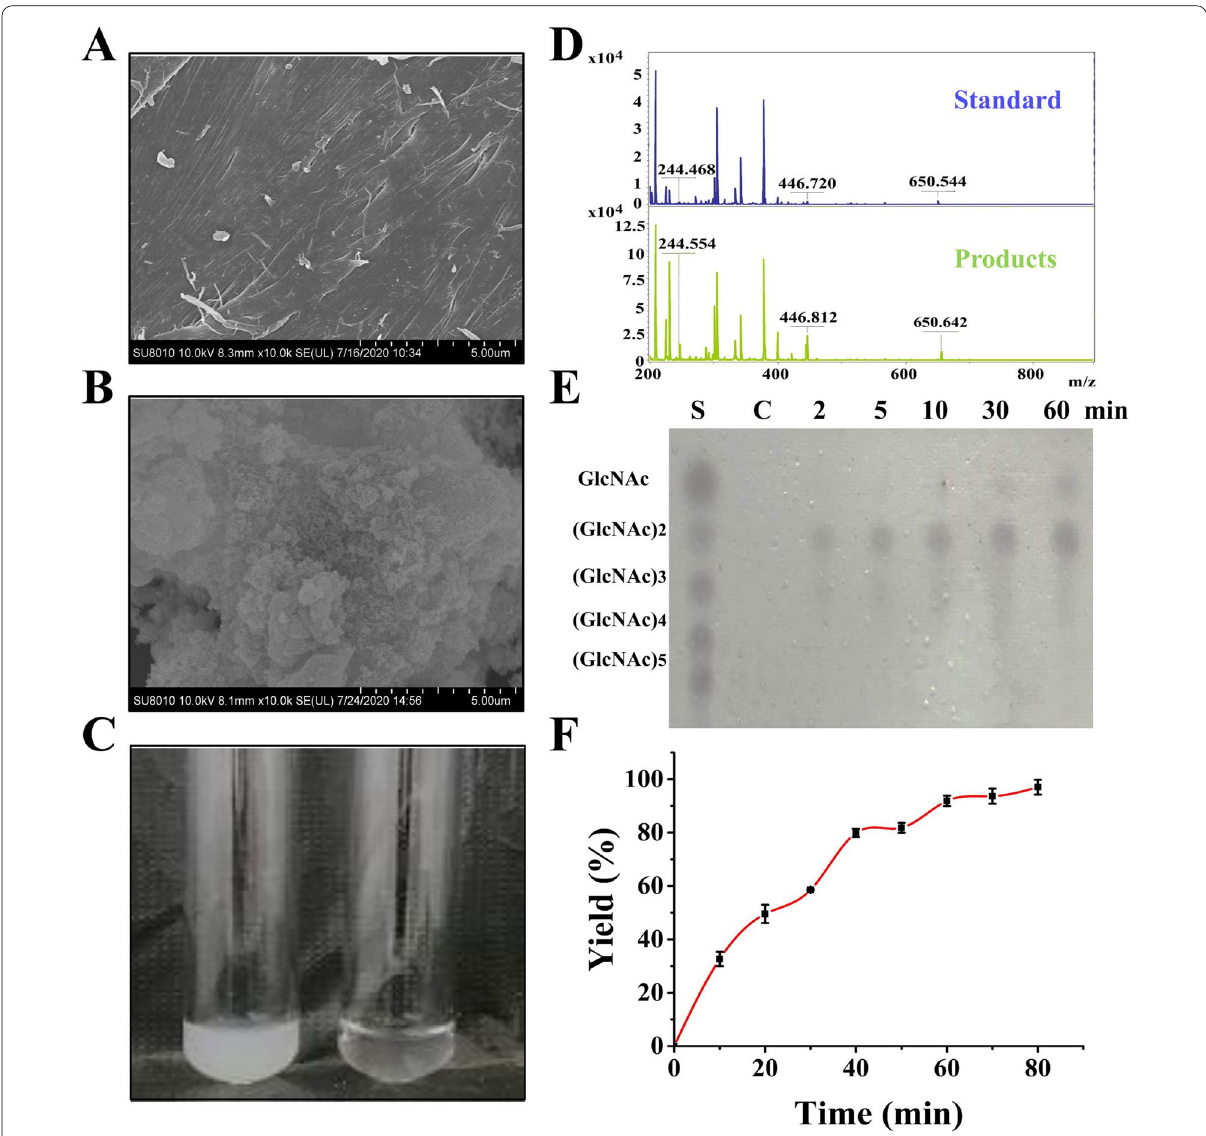
Fig. 4 Detection of colloidal chitin degradation. A The surface morphology of crude chitin powder observed by SEM. B The surface morphology of colloidal chitin observed by SEM. C The changes of colloidal chitin before and after Chi304 enzymolysis. D MALDI-TOF detection of colloidal chitin degradation; standard, 5 mg mL − 1 (GlcNAc) 1–6 mixed standard. E Detection of colloidal chitin hydrolysis by TLC; S, 50 mg mL − 1 (GlcNAc) 1–5 mixed standard. F Yields of reducing sugar products of colloidal chitin